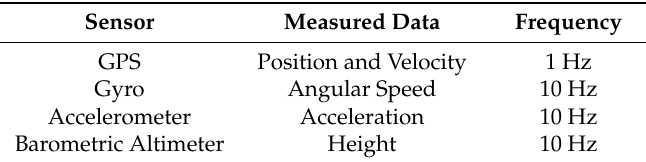
Table 1. The measured data and sampling rate used for each sensor.